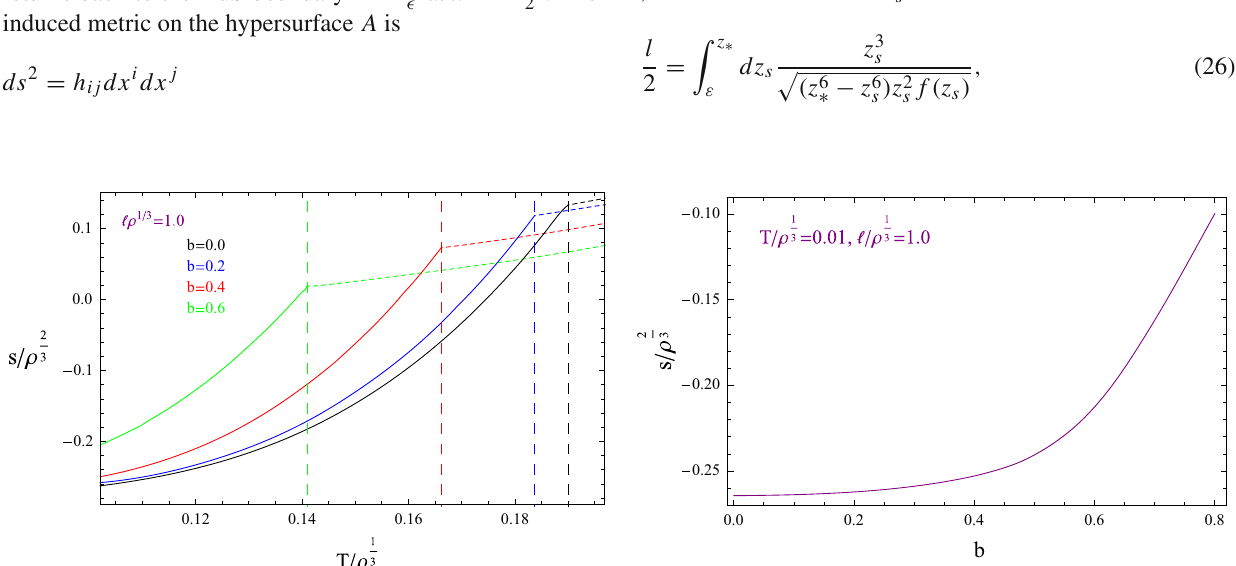
Fig. 2 The entanglement entropy of the operator (cid:2) O + (cid:3) with respect to the temperature T and BI factor b for (cid:14)ρ 1 3 = 1. The four lines in left plot from top to bottom correspond to b = 0 (black), b = 0 . 2 (blue), b = 0 . 4 (red), and b = 0 . 6 (green)